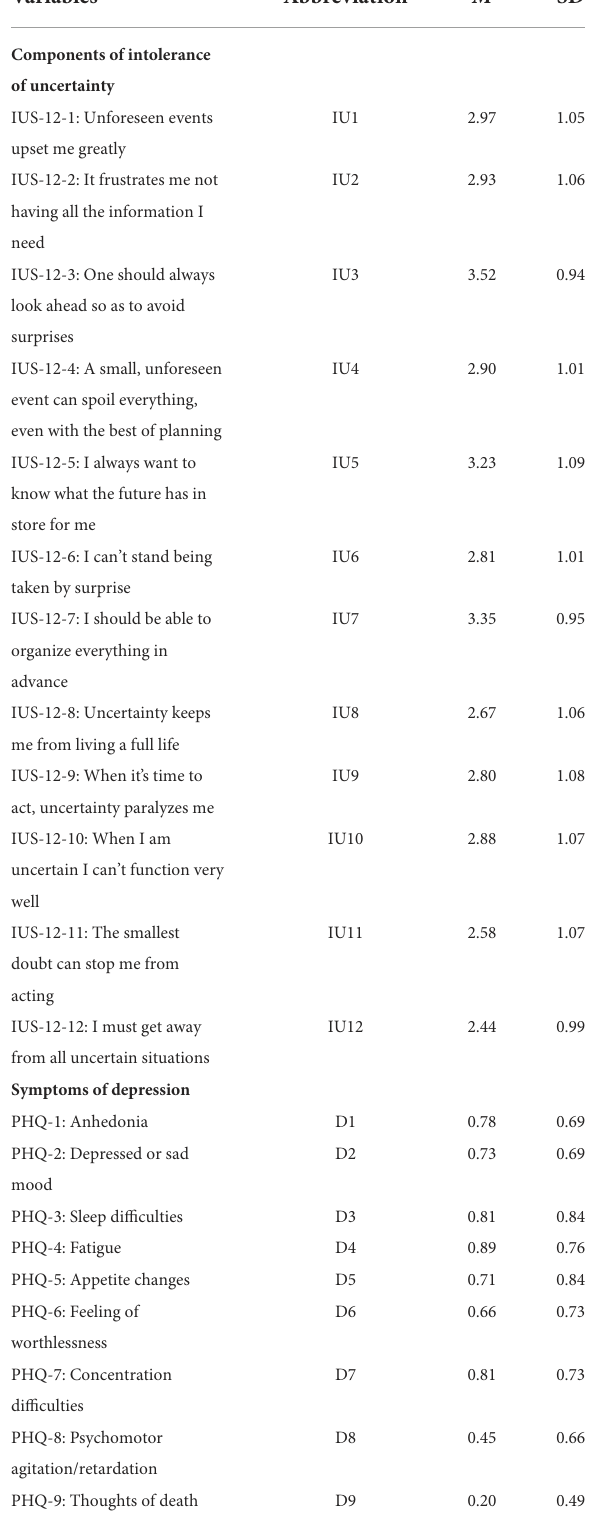
TABLE 1 Abbreviations, mean scores, and standard deviations for each variable selected in the present network.